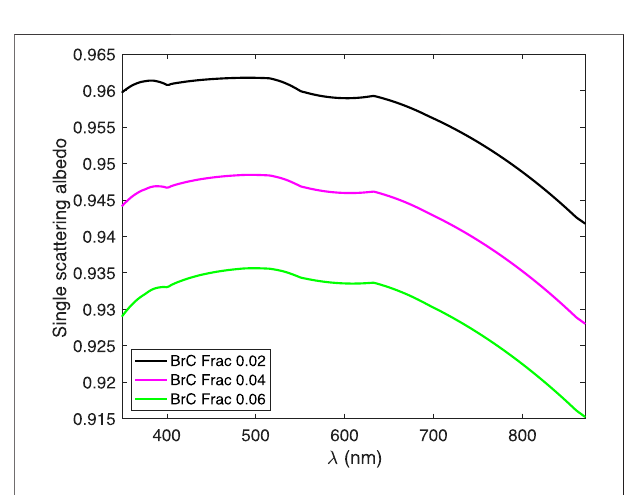
FIGURE4| Thesinglescatteringalbedoofthethreeaerosolmodelswith the brown carbon volume factions of 0.02, 0.04, and 0.06 in the fi ne